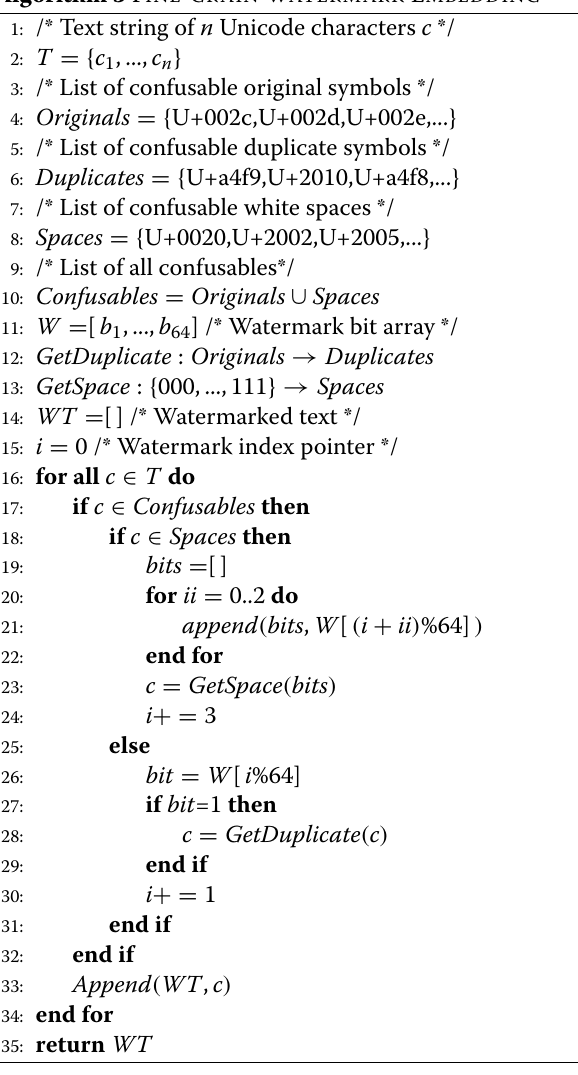
Algorithm 3 F INE - GRAIN W ATERMARK E